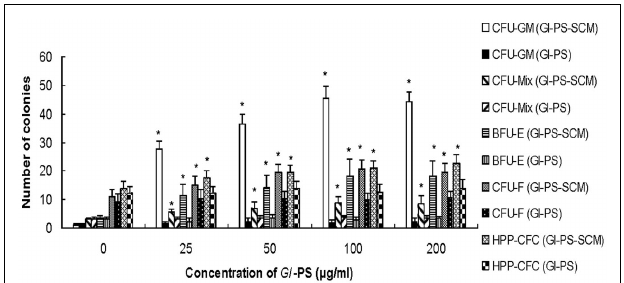
FIGURE 1 | Effect of Gl -PS and Gl -PS–SCM on the clonogenic activities of various hematopoietic progenitor cells and stromal cells in bone marrow in vitro . Splenocytes (1 × 10 7 ) were cultured in complete RPMI-1640 medium with Gl -PS ( Gl -PS–SCM) at various concentrations (0–200 μ g/ml) or with phytohemagglutinin (PHA) at a final concentration of 10 μ g/ml (PHA–SCM). After 48h, the supernatants were collected for clonogenic assays. Bone marrow cells (BMC, 5 × 10 4 /well) were plated on CFU-GM, BFU-E, and CFU-Mix culture systems containing Gl -PS (0–200 μ g/ml) alone or Gl -PS–SCM induced by Gl -PS (0–200 μ g/ml). Colony numbers were counted (CFU-GM on day 7, BFU-E on day 7–10, and CFU-Mix on day 12). BMC (10 5 ) were collected from 5-FU-treated mice and were cultured for 14days in a HPP-CFC culture supplemented with 20% (v/v) Gl -PS or Gl -PS–SCM. * P < 0.05 versus control (concentration of Gl -PS: 0 μ g/ml).The colony-stimulating activities of PHA–SCM, which served as a positive control, were 31.4 ± 4.5 for CFU-GM, 12.1 ± 2.6 for BFU-E, 4.5 ± 1.2 for CFU-Mix, 16.2 ± 4.0 for CFU-F, and 21.2 ± 3.5 for